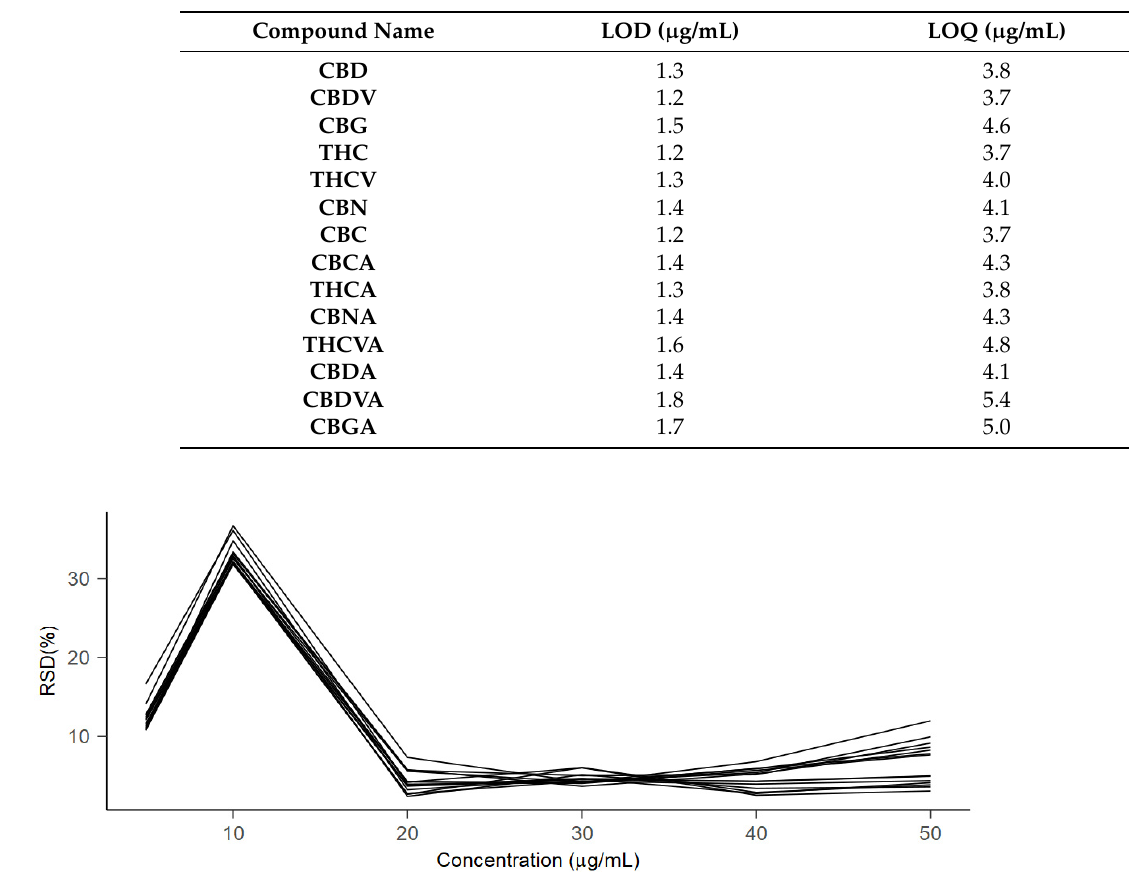
Table 1. Limits of detection (LOD) and quantification (LOQ) for cannabinoid compounds ( n = 7).